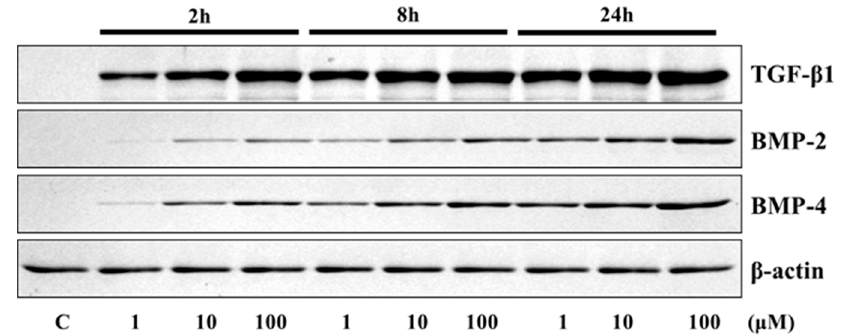
Figure 1. Western blot analysis for transforming growth factor- β 1 (TGF- β 1), bone morphogenic protein-2 (BMP-2), and BMP-4. Expression levels were increased after 4HR administration.